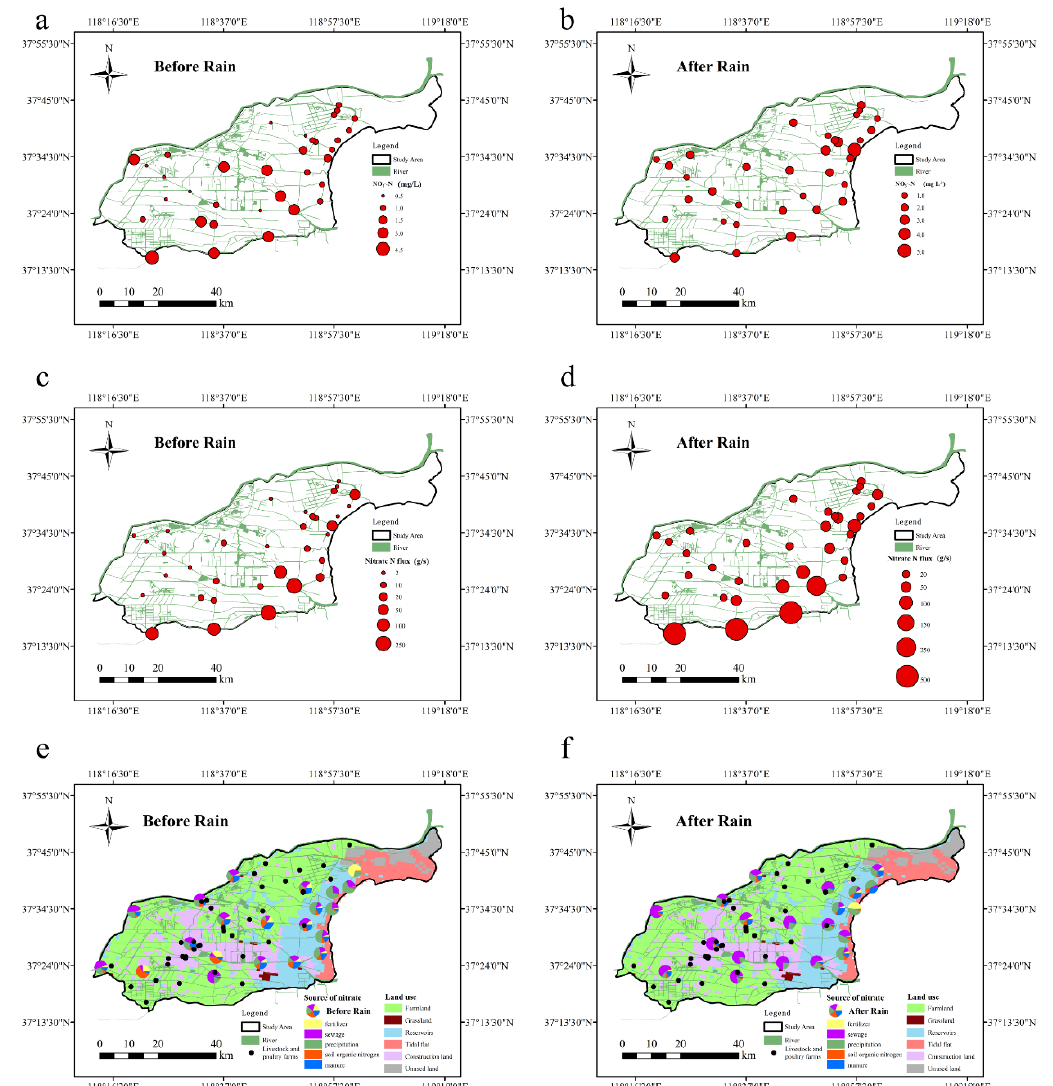
Figure 6. Spatial characteristics of surface water nitrate N concentrations ( a , b ), instantaneous fluxes ( c , d ), and source contribution ratios ( e , f ) before and after rains in the study area.